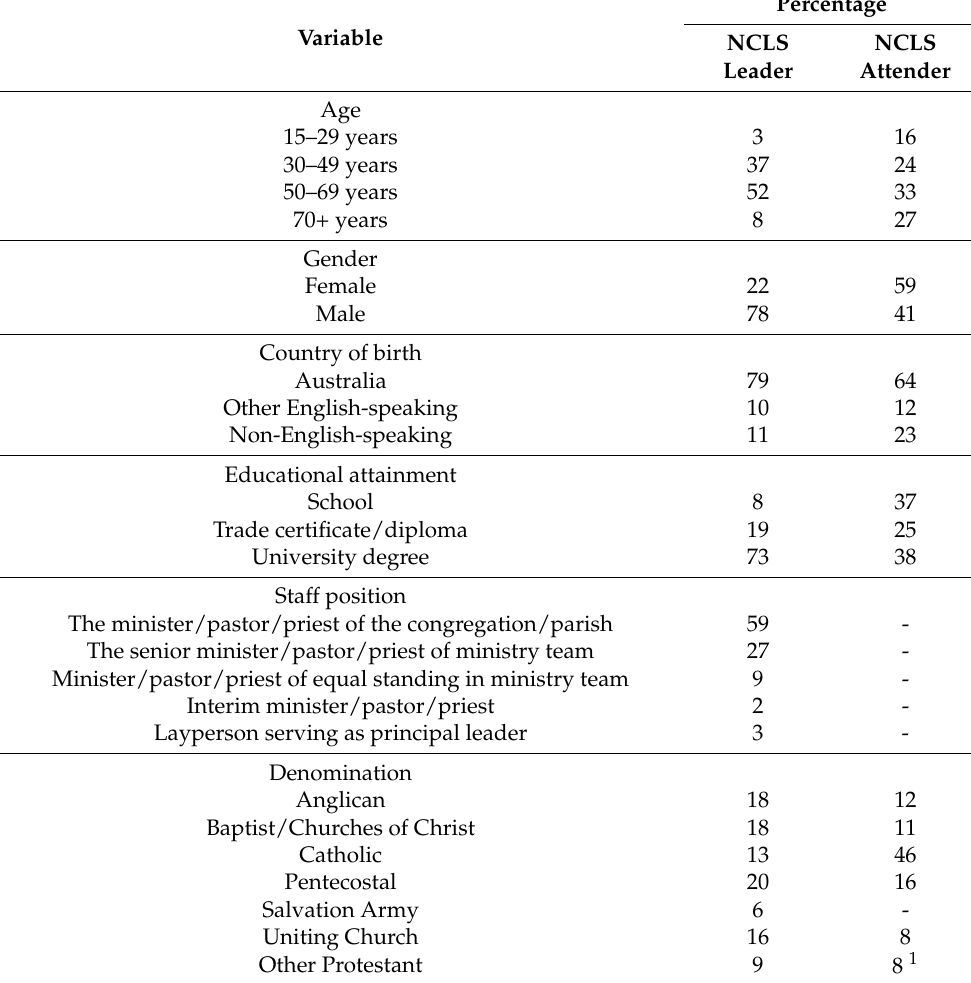
Table 1. Demographics of NCLS